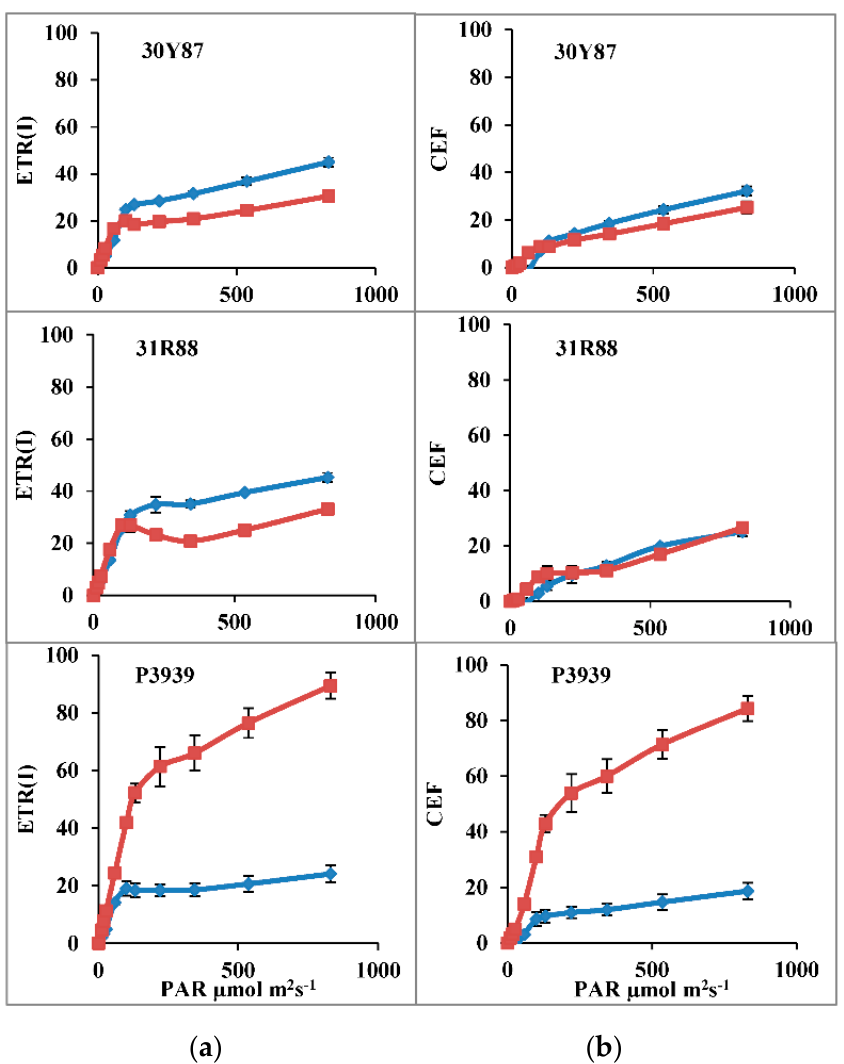
Figure 3. Changes in ETR(I) and CEF of three maize hybrids when two-week-old plants were subjected to three cycles of drought stress. ( a ) Electron transport rate in PS(I) [ETR(I)] and ( b ) Cyclic electron flow [CEF]. Blue lines are control, red lines with markers are water stress. Bars represent the calculated standard error ( n = 4).